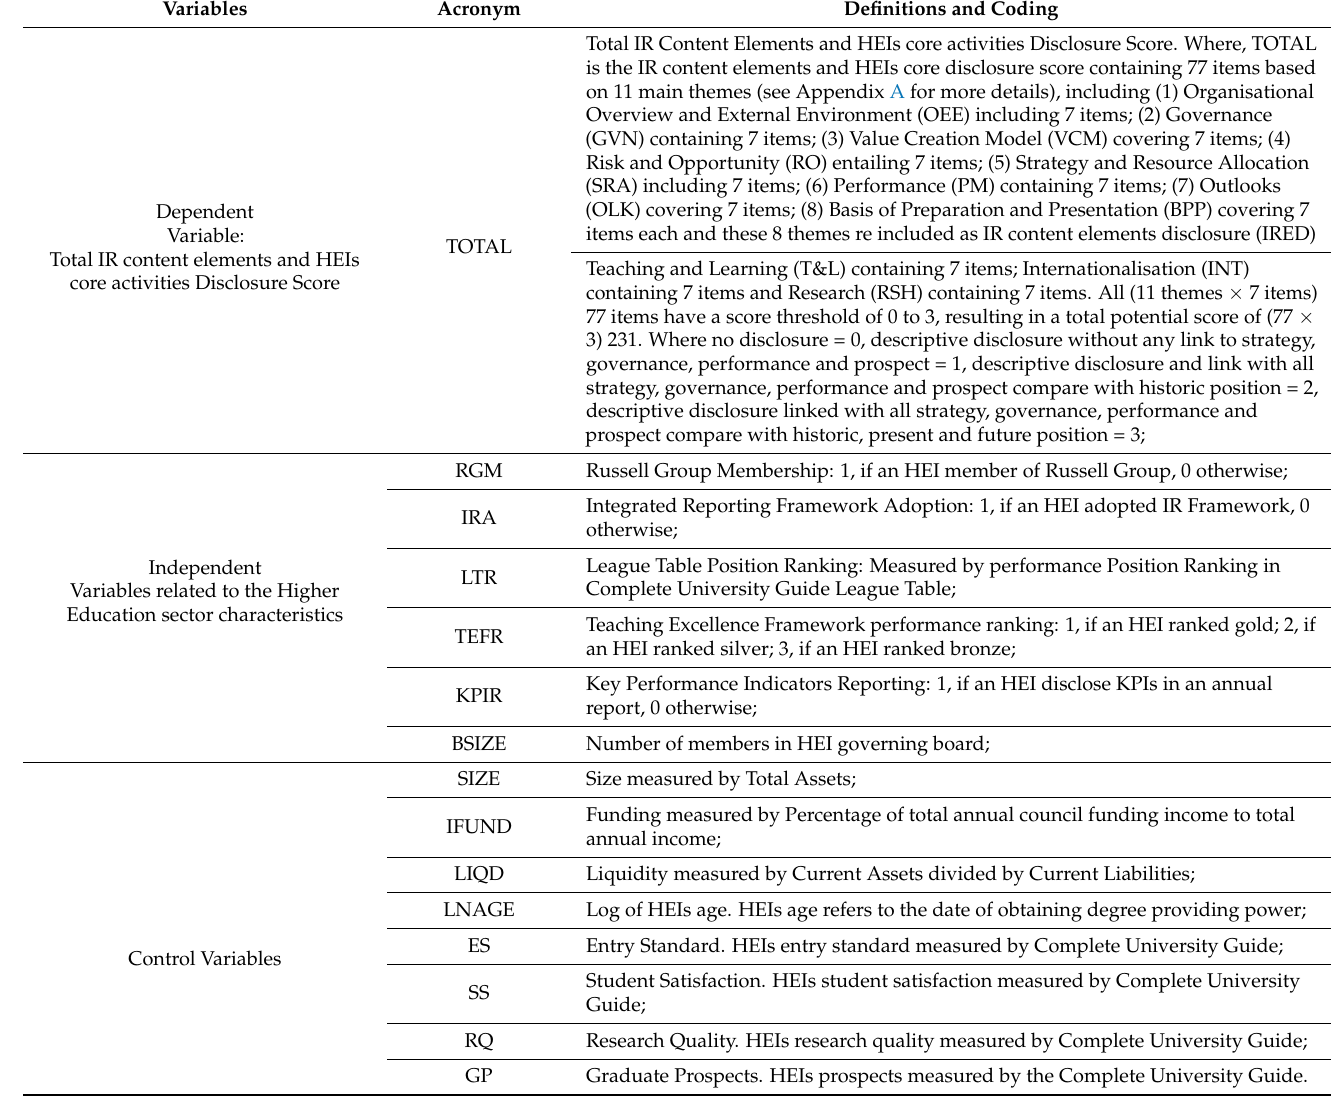
Table 1. Summary of variables and measurement.